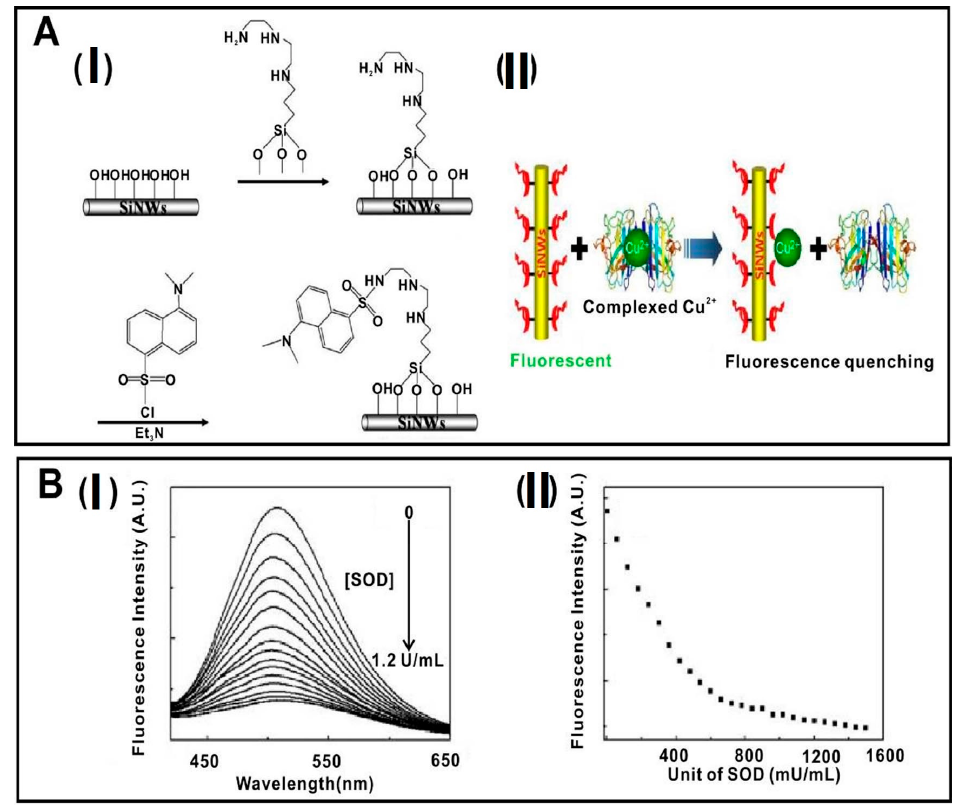
Figure 7. SiNW-based fluorescent sensors for the detection of complexed Cu 2+ . ( A ): ( I ) Schematic illustration of procedures of the functionalization of SiNWs; ( II ) schematic illustration of SiNW-based sensors for the detection of complexed Cu 2+ based on fluorescence quenching; ( B ) fluorescence spectra of SiNWs-based sensors with addition of Cu-Zn-superoxide dismutase (SOD1) unit ( I ) and its corresponding titration curve ( II ); λ ex = 350 nm, λ em = 505 nm. Reproduced with permission from [69]. Copyright 2014, American Chemical Society.